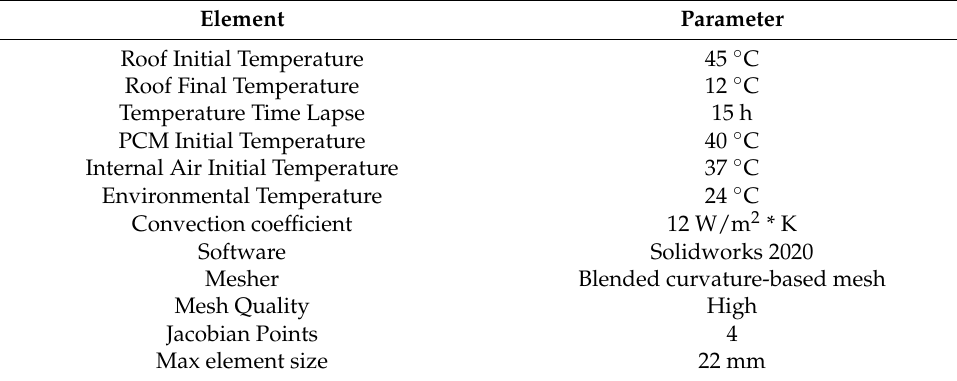
Table 4. Boundary conditions for